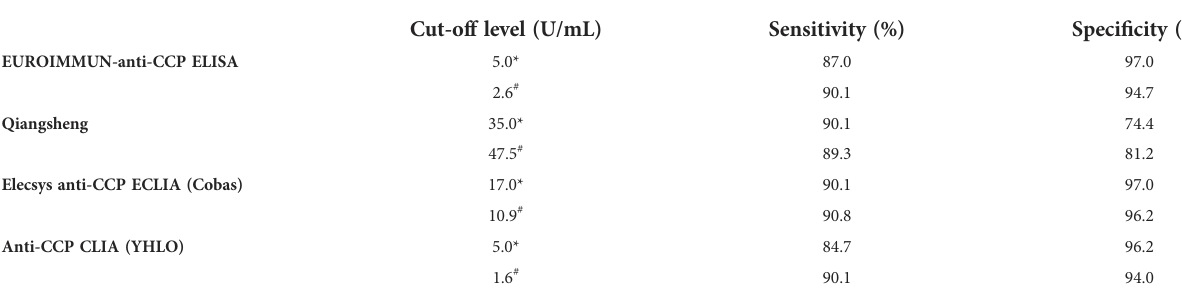
Table 4 Diagnostic performance.